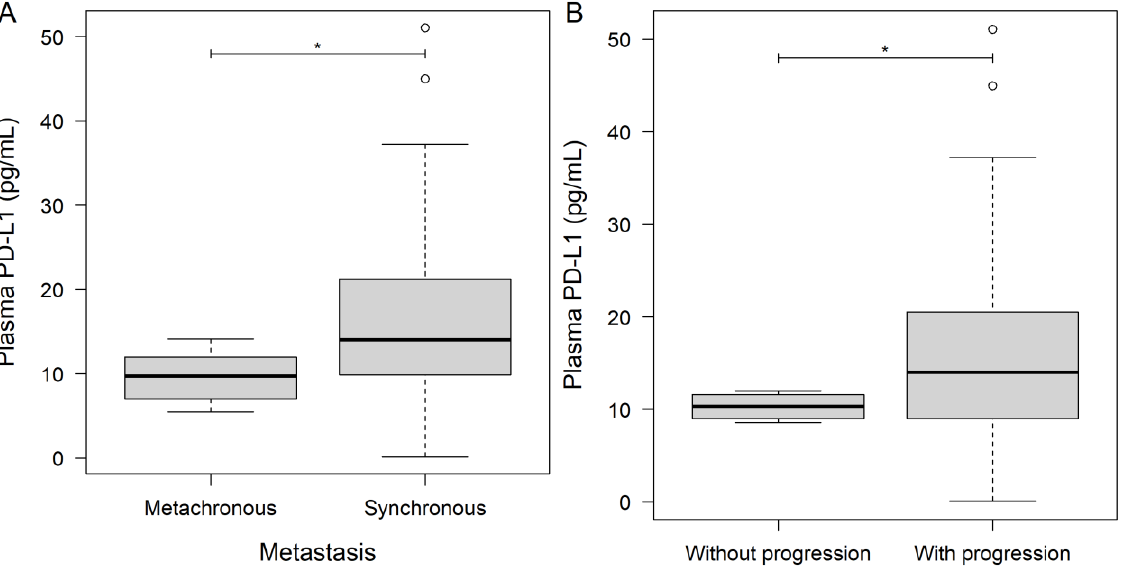
Figure 1. Pre-treatment measurements of plasma programmed death-ligand 1 (PD-L1) of metastatic colorectal cancer patients with ( A ) synchronous ( n = 31) and metachronous ( n = 6) metastases, and ( B ) who had disease progression ( n = 33) or not ( n = 4) during our observation period. Thick lines and hollow circles represent median and outliers, respectively. * p <